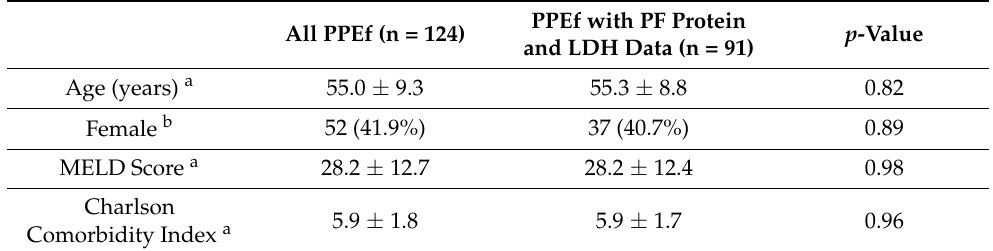
Table A2. Baseline characteristics of persistent pleural effusion (PPEf) cohort vs. PPEf subset with available pleural fluid protein and lactate dehydrogenase data.